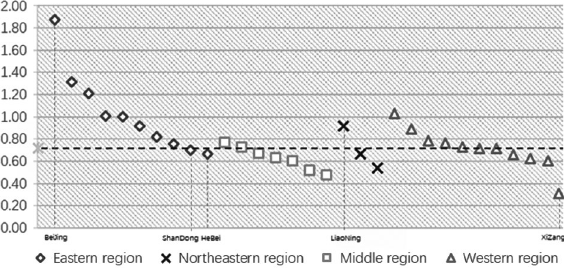
Figure 2. Spatial distribution of green finance